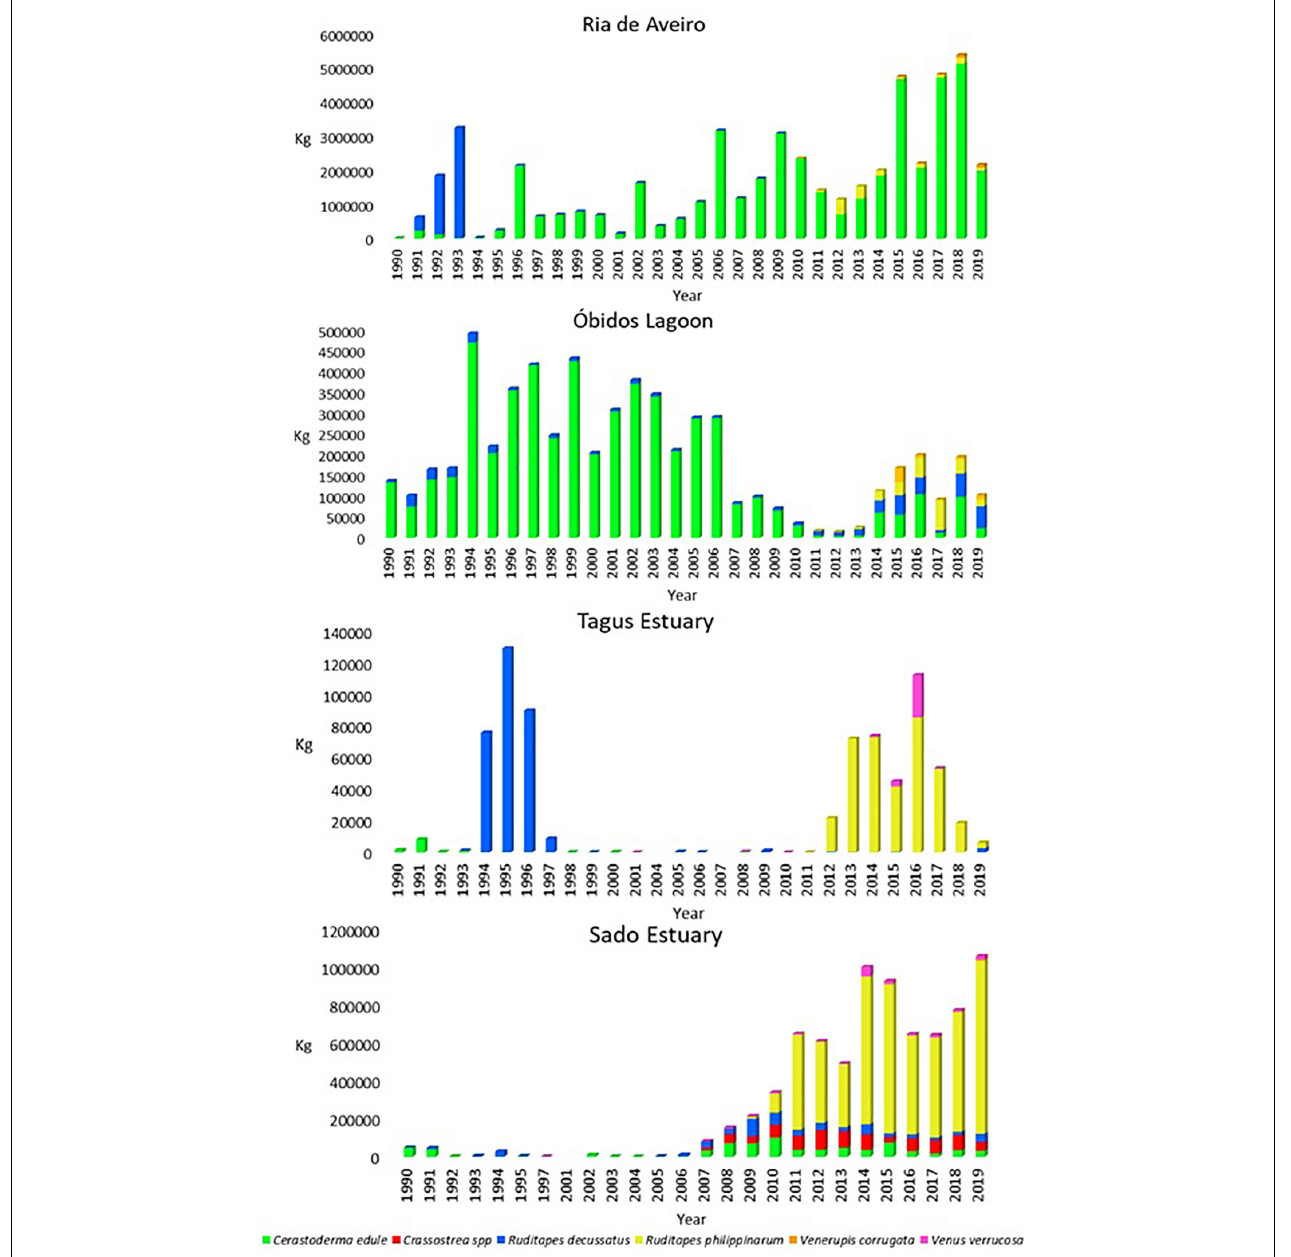
FIGURE 2 | Annual landings of the bivalve species in Ria de Aveiro, Óbidos lagoon, Tagus estuary and Sado estuary between 1990 and 2019 (Source: DGRM,